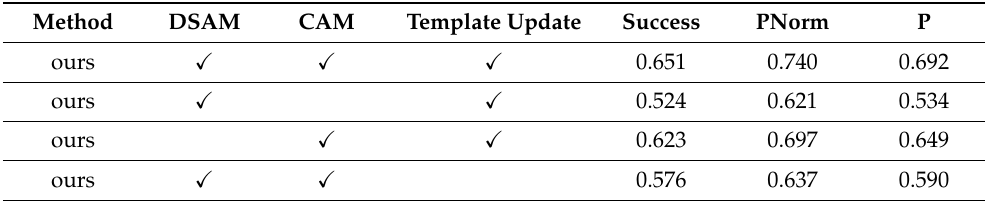
Figure 10. The registration effect of algorithm in different cases. Table 8. Ablation results on LASOT